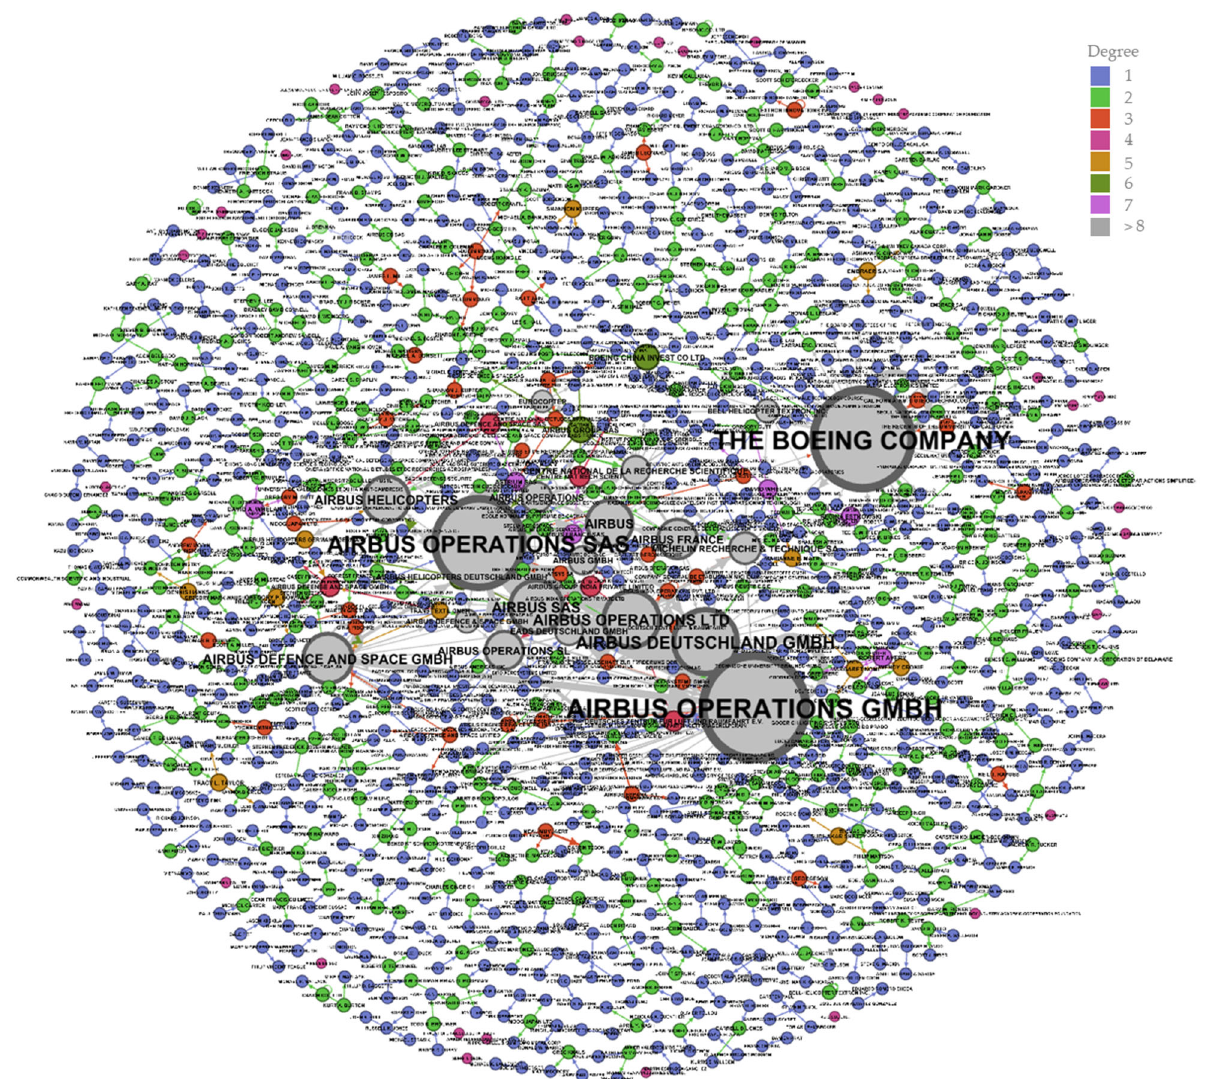
Figure 13. Network Analysis of UAM Technology.